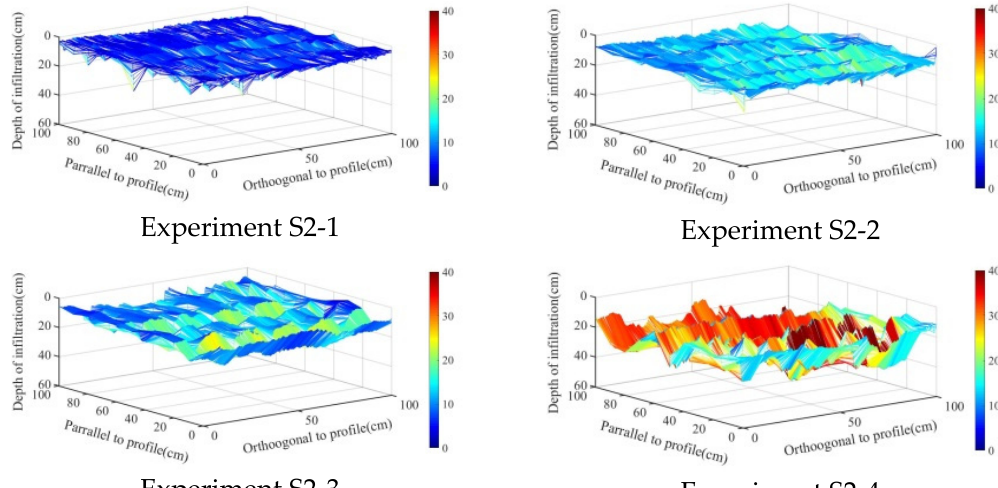
Figure 5. Spatial distribution of infiltration depth under experiment S1.